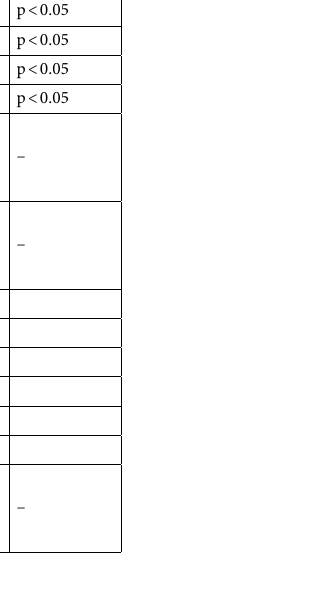
Table 1. Demographic and injury-related variables.